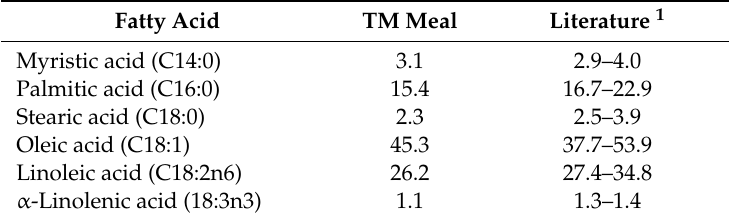
Table 4. Fatty acid content of T. molitor (TM) meal used in the study compared to the literature (g / 100 g of EE).